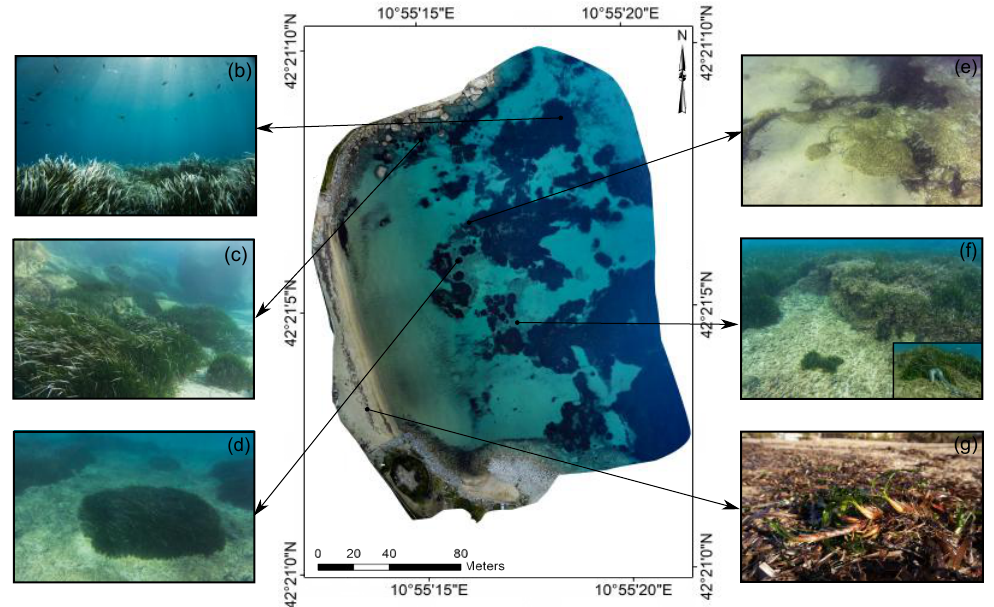
Figure 5. High-resolution orthophoto (2.76 cm/pix) of the Posidonia oceanica meadow in front of the beach of Cannelle ( a ). Important underwater features characterizing this environment are shown trough underwater photos used as ground truth data. P. oceanica seagrass meadow ( b ), patch formation of the seagrass on rocks ( c ) and sand ( d ), dead leaves of Posidonia oceanica lying on the sea bottom ( e ), impacted areas from boat anchoring with exposed root-rhizomes ( f ), and accumulation areas of beached leaves and rhizomes ( g